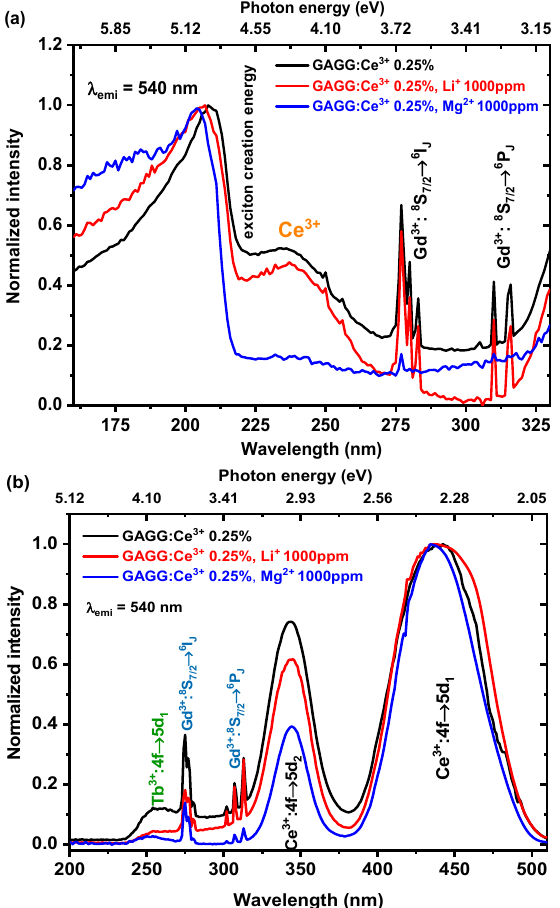
Figure 5. ( a ) Vacuum UV excitation spectra for Ce 3+ emission at 540 nm (2.29 eV) measured using synchrotron radiation between 160 and 330 nm; ( b ) excitation spectra for Ce 3+ emission measured using Xe lamp radiation between 200 and 510 nm for Ce 3+ , Ce 3+ :Li + , and Ce 3+ :Mg 2+ doped GAGG single crystals, 300 K.